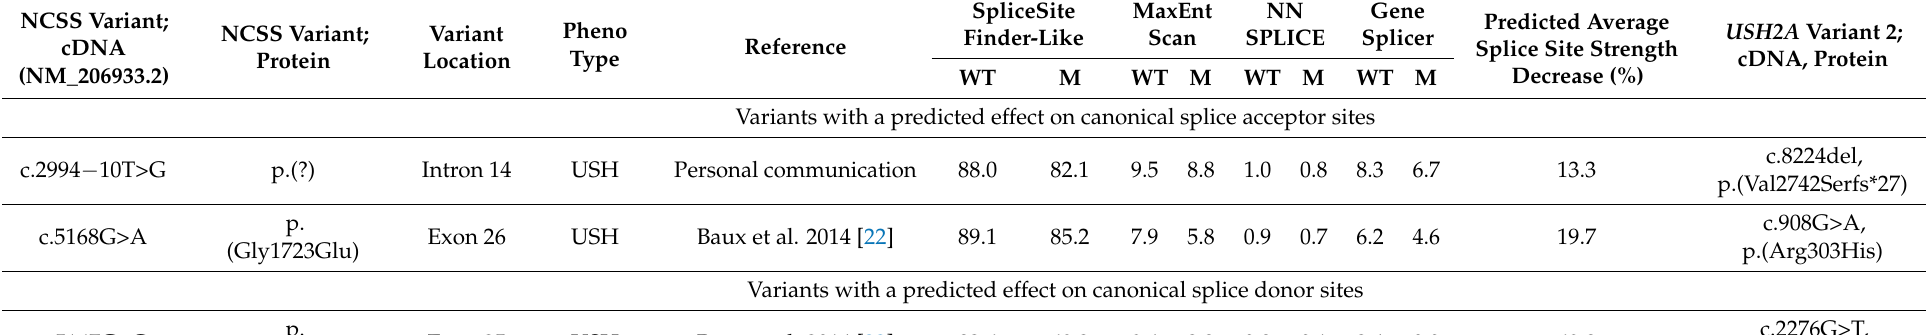
Table 1. Non-canonical splice site variants that were selected for a minigene splice